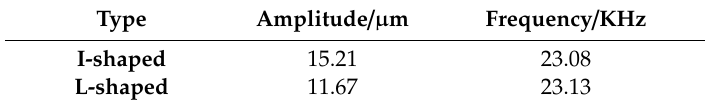
Table 3. Actual output amplitude and resonance frequency of different ultrasonic vibration systems.